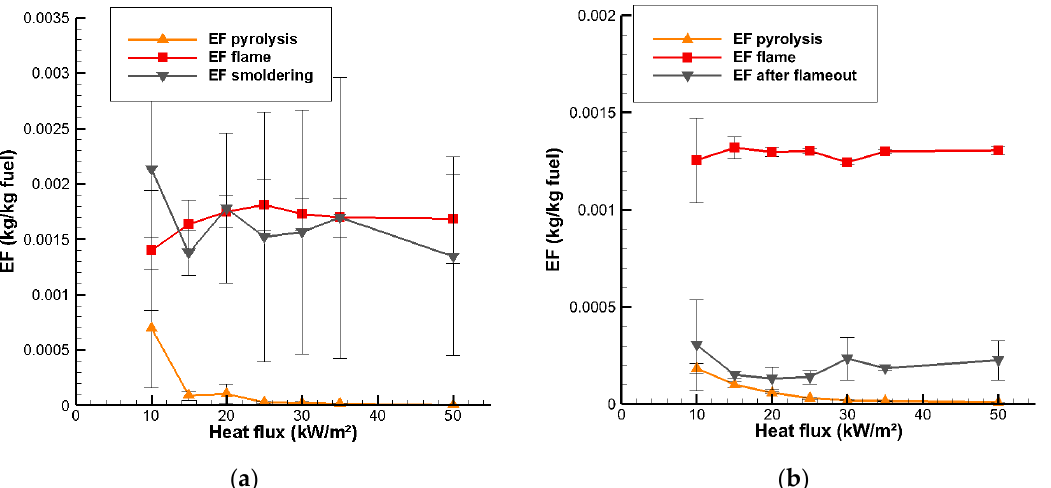
Figure 15. EF for NO for an imposed heat flux ranging from 10 to 50 kW/m 2 for ( a ) wood and ( b ) thermoplastic samples.